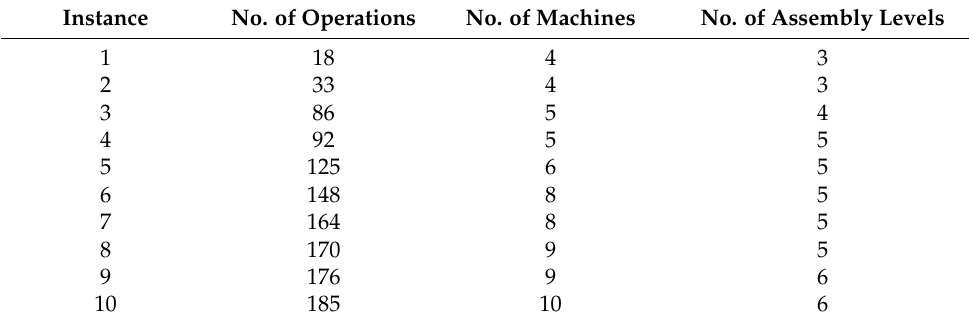
Table 3. Characteristics of test instances.